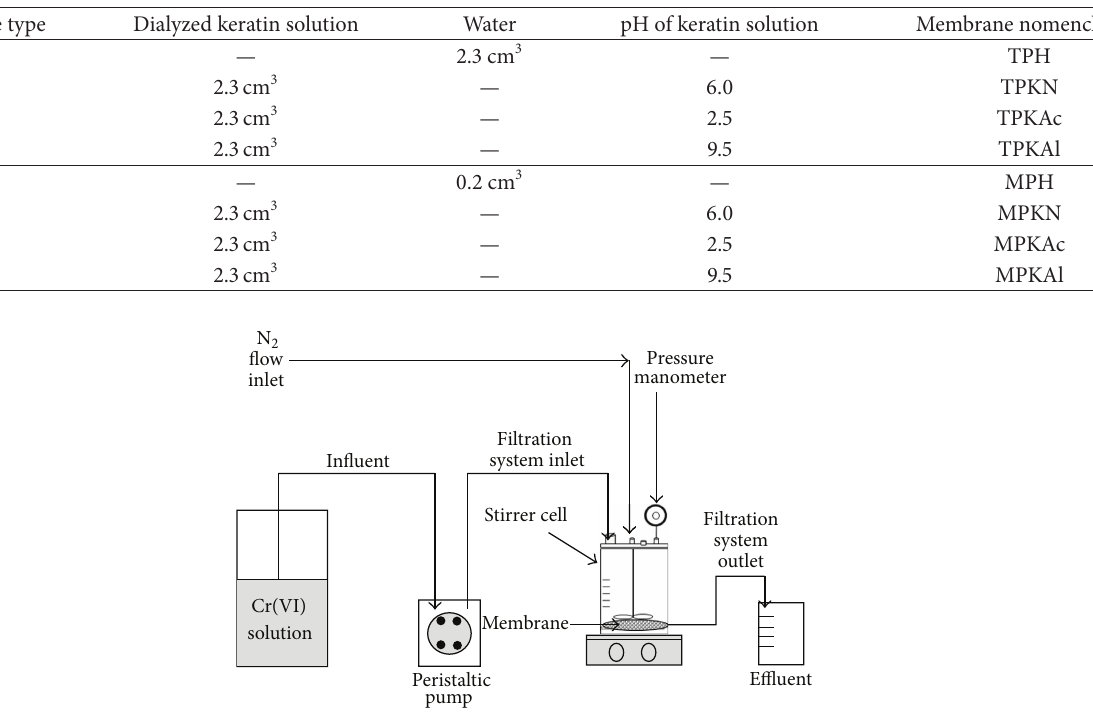
Table 1: Nomenclature and components of polyurethane-keratin membranes.